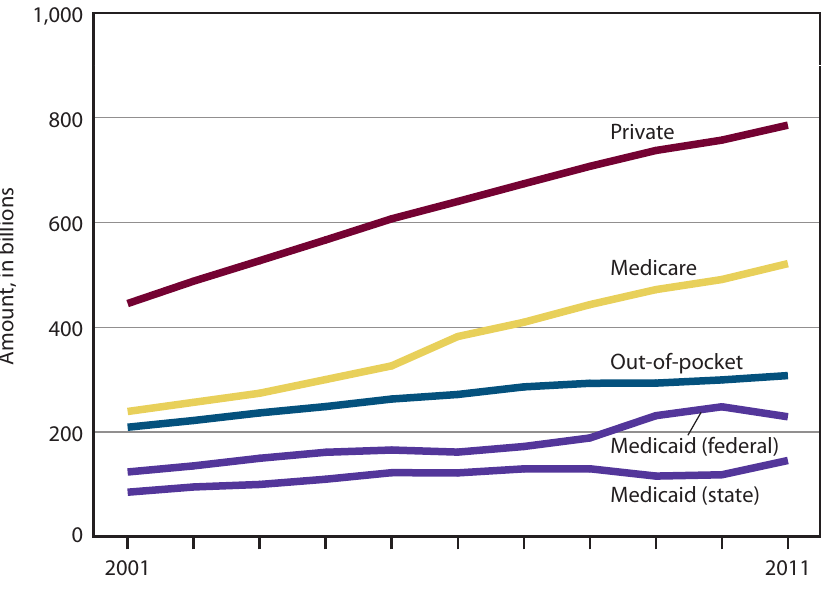
Figure 19. Personal health care expenditures, by source of funds: United